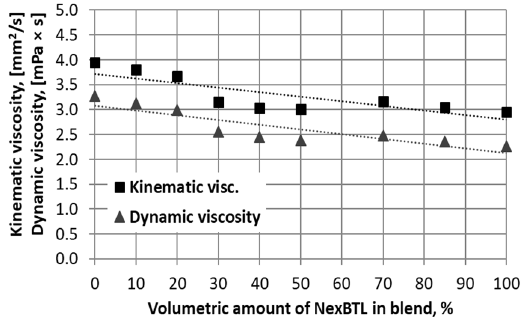
Figure 2. Dependence of the dynamic and kinematic viscosities (40 °C) on percentage of NexBTL in fuel blends.